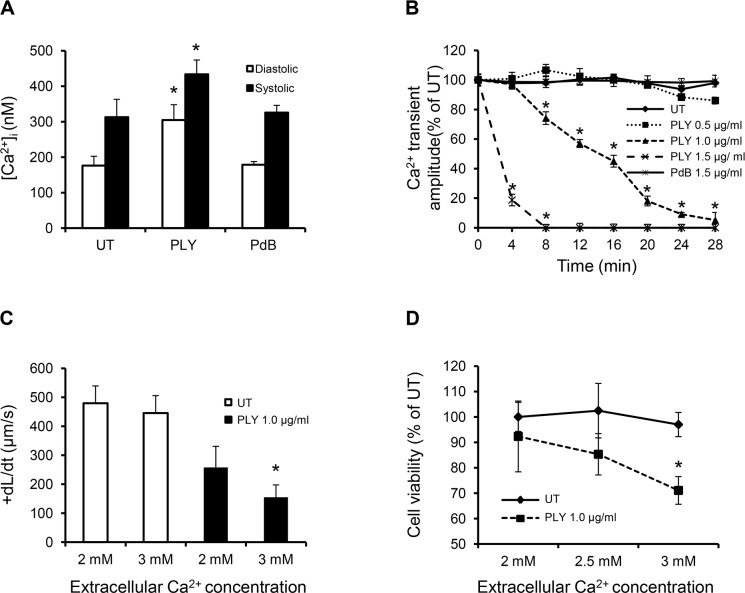
Profound calcium influx induces cardiomyocyte dysfunction and injury in response to sub-lytic PLY.(A) Mean±SD of both systolic and diastolic [Ca2+]i of HL-cells within 1 min of treatment with PLY/PdB (1.0 μg/ml) from 4 independent experiments are presented. *p<0.05. (B) Change in intracellular Ca2+ transient amplitude over 30 min in response to different concentrations of PLY. Ca2+ transient amplitude at 0 min was set at 100%. Data are presented as Mean±SD (n = 4). (C) and (D) The effects of changing extracellular Ca2+ concentration (in media) of HL-1 cells from 2 to 3 mM on +dL/dt (C) and cell viability (D) in the absence (UT) and presence of 1.0 μg/ml PLY. Mean±SD from 3 independent experiments are presented. * p<0.01 when compared to 2 mM extracellular Ca2+.